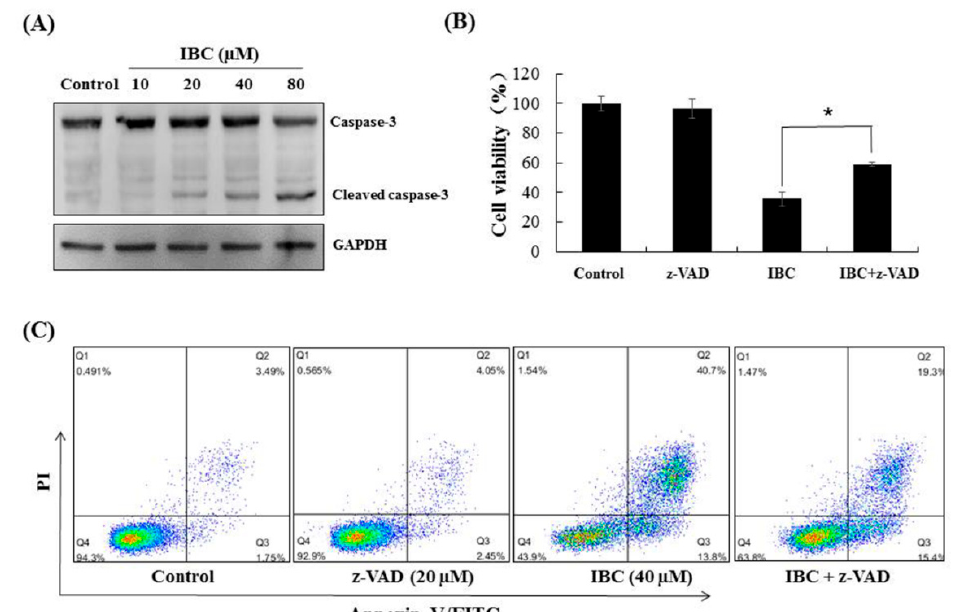
Figure 4. IBC induced caspase-3 dependent apoptosis in MDA-MB-231 cells. ( A ) Western blotting analysis of caspase-3. ( B ) Cell viability following treatment with IBC (40 µM) for 24 h alone or with the pan-caspase inhibitor z-VAD-FMK (20 µM) pre-treatment as measured by the MTT assay. ( C ) Annexin V-FITC/PI analysis following treatment with IBC with or without pre-treatment with z-VAD-FMK. * p < 0.05 compared between the groups of IBC and IBC with z-VAD-FMK.